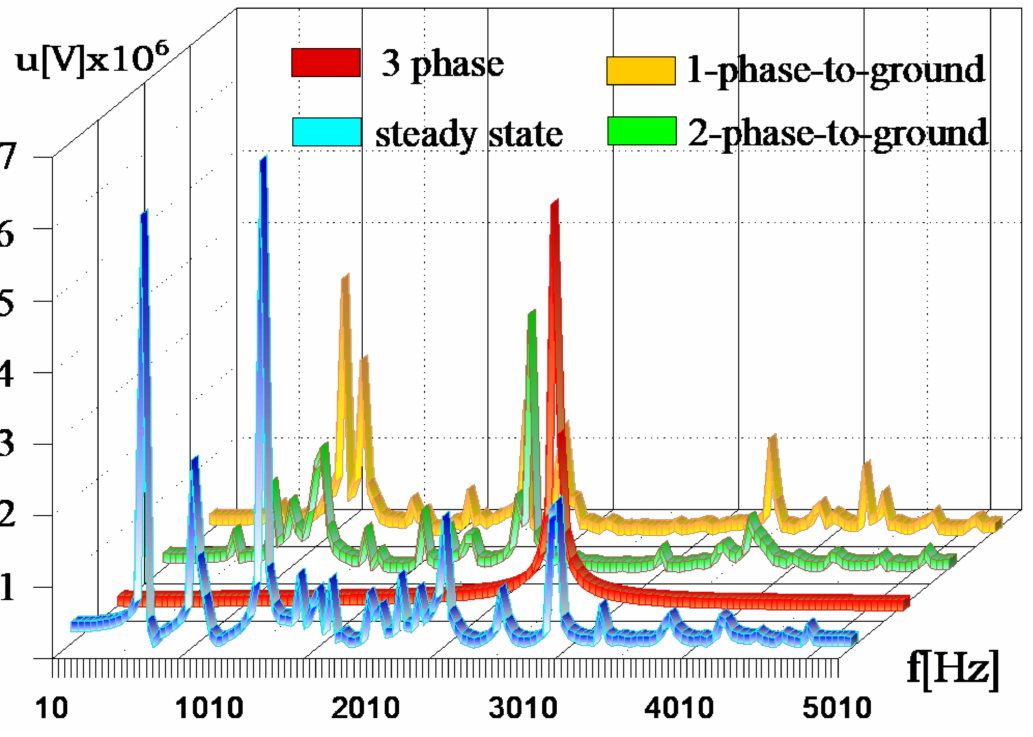
Figure 4. Frequency response for different fault